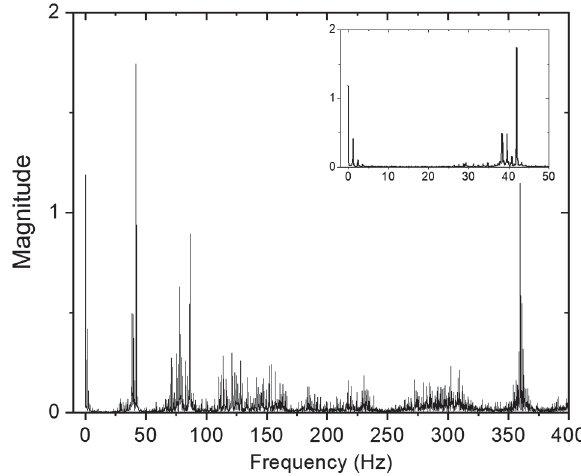
FIG. 31. Magnitude of the FFT of δ f ð t Þ shown in Fig. 30. The inset shows an expanded view of the peaks below 50 Hz.